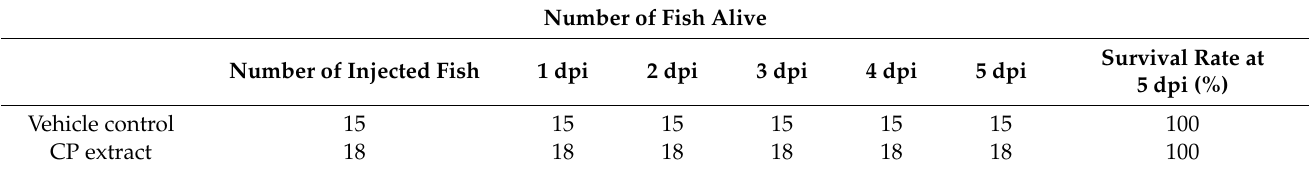
Table 1. Survival of fish injected with cranberry pomace extract from 1 day to 5 days post injection (dpi).